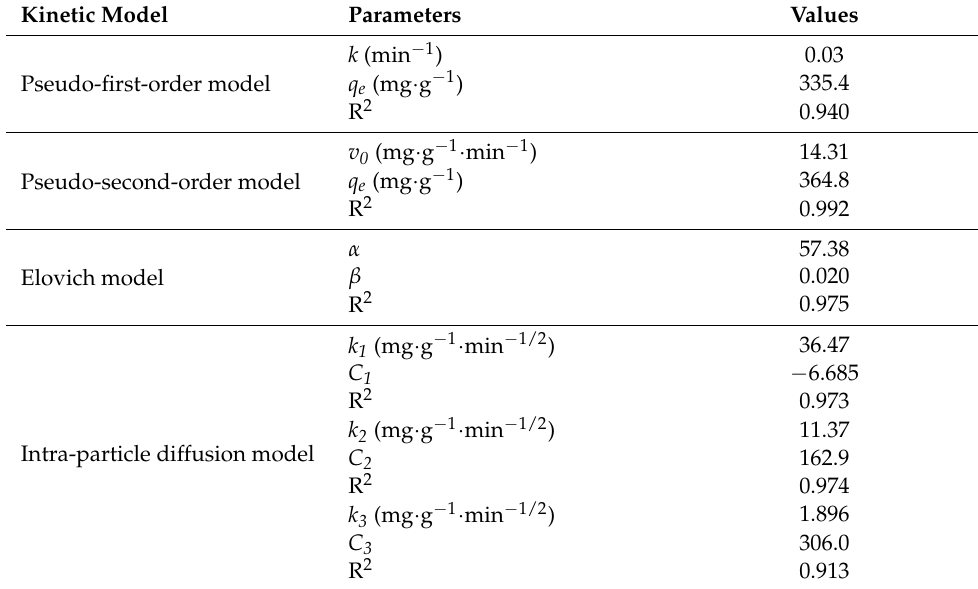
Table 1. Fitting results of kinetic model parameters for TC onto Alg-Cu@GO@MOF-525. Kinetic